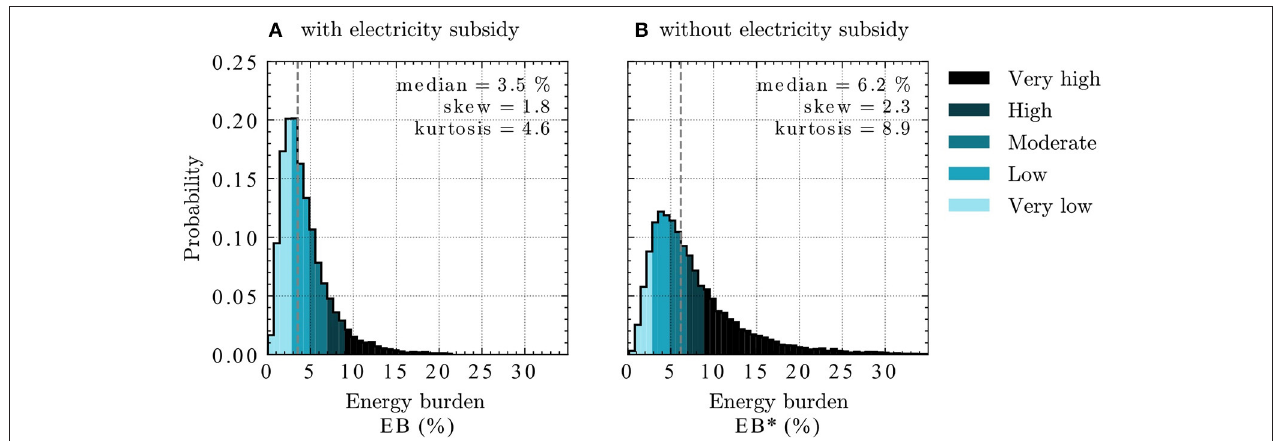
Frontiers in Sustainable Cities |